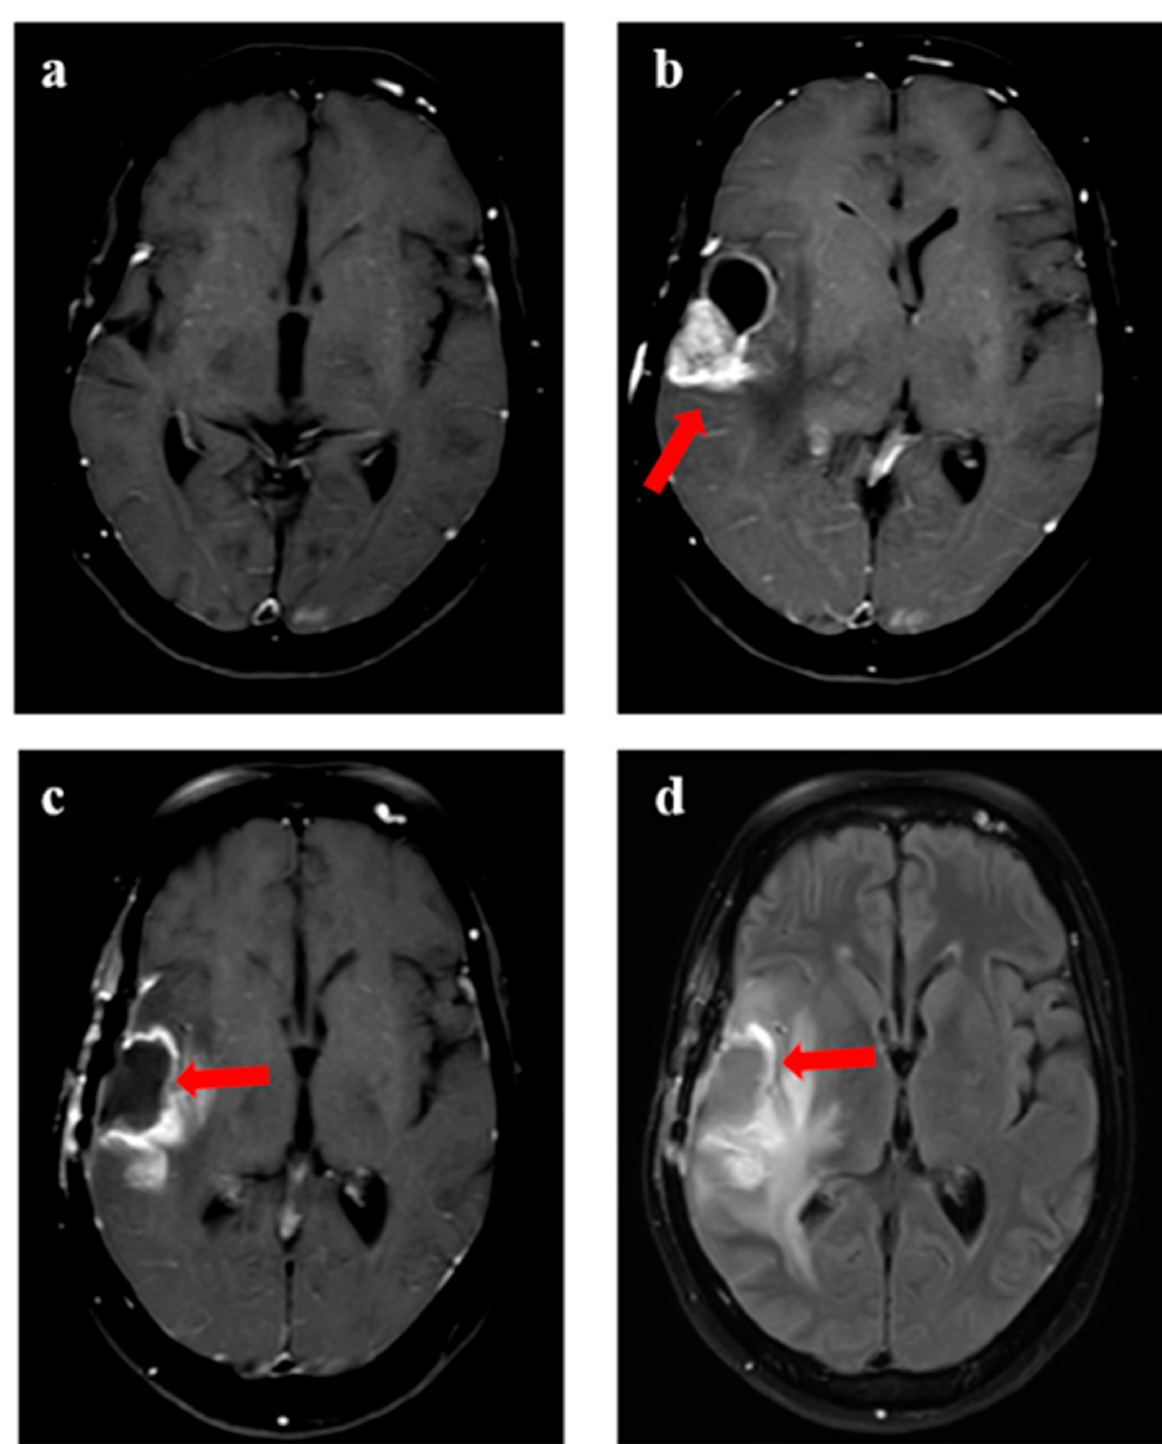
Figure 3. Progression in a 47-year female with glioblastoma with MGMT gene promoter methyla- tion. ( a ) shows T1w axial view following completion of adjuvant chemotherapy (after surgery and radiation), with ( b ) showing local recurrence after 2.5 years with enhancing component and cystic component (arrow). ( c , d ) represented the surgical cavity on T1w contrast and T2w FLAIR axial view when the patient was considered for reirradiation.